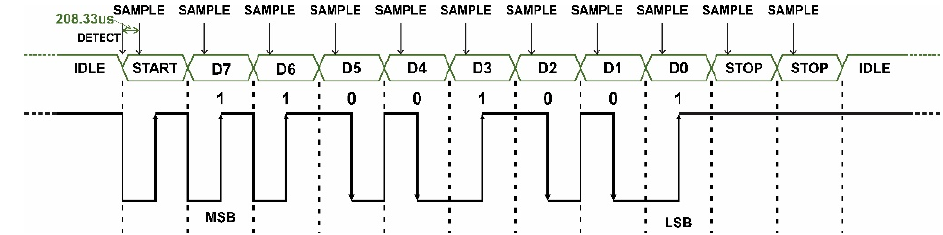
Figure 13. Sampling the reception data in Manchester encoding.